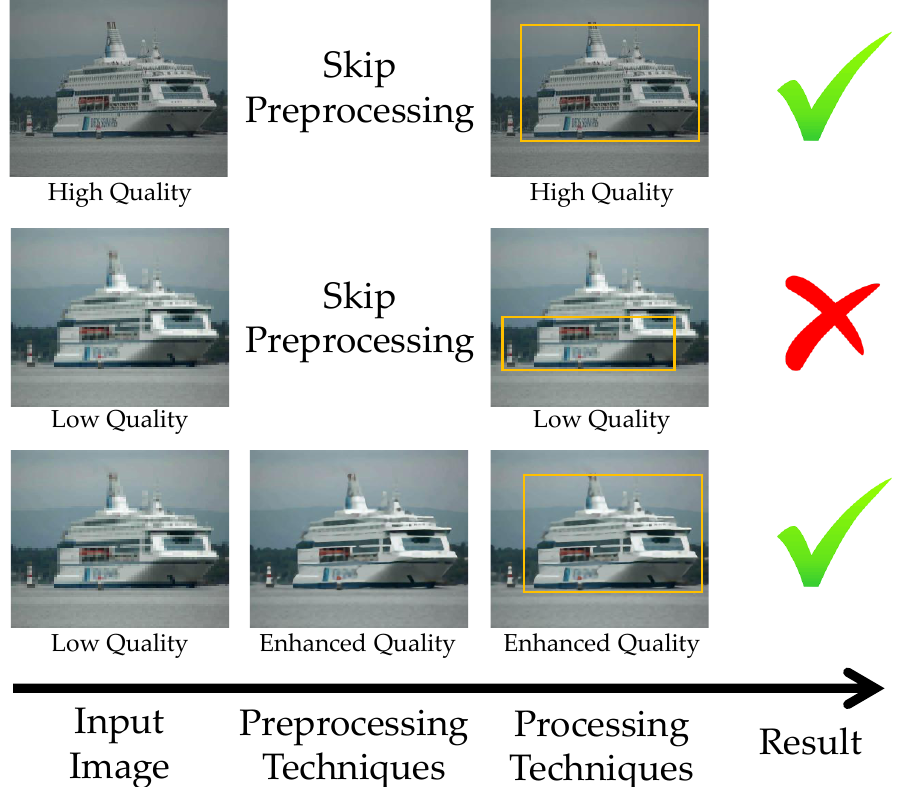
Figure 2. Detection enhancement with